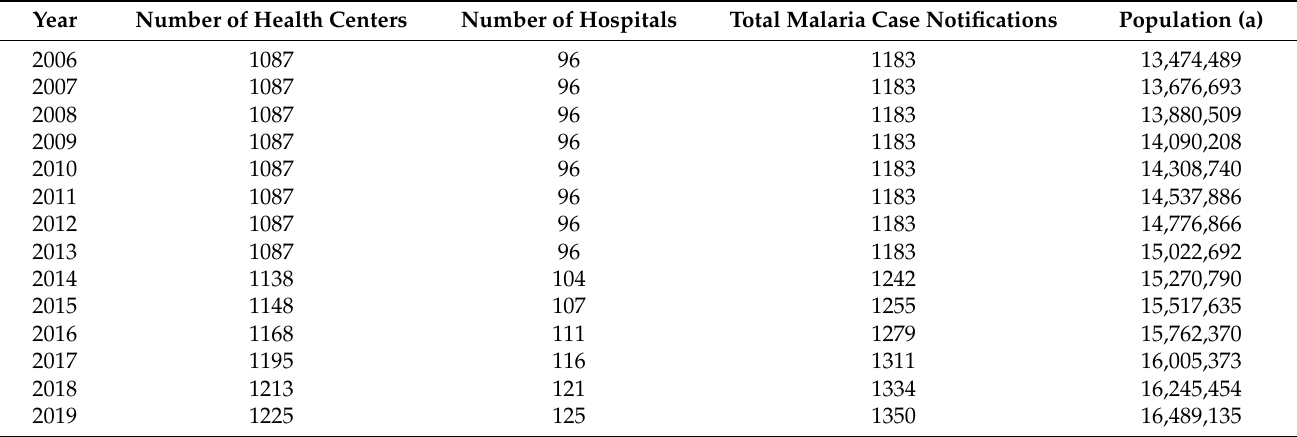
Table 1. Number of health centers and hospitals by year, reporting to the Health Management Information System (HMIS), Cambodia, 2016 and